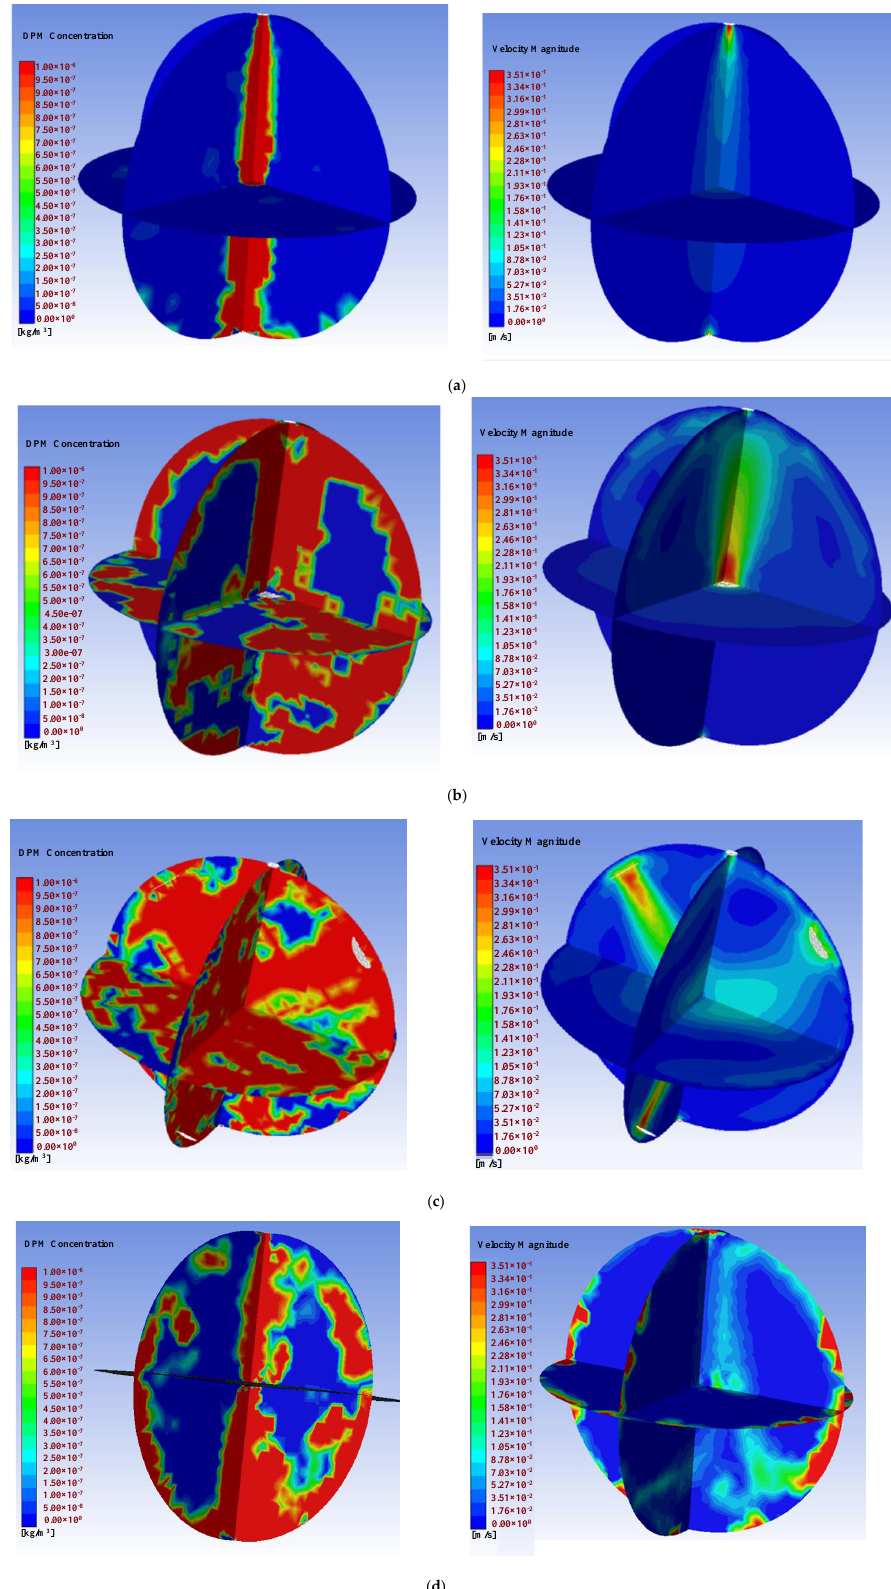
Figure 6. Particle-concentration and wind-speed simulation results under different wind fields: ( a ) No fan; ( b ) 1 fan with a pressure of 0.1 Pa in front of and behind the fan; ( c ) 4 fans with a pressure of 0.1 Pa; ( d ) 1 fan with a pressure of 0.5 Pa.